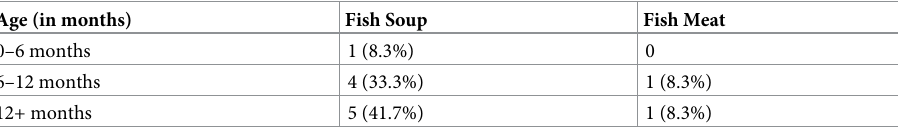
Table 3. Number of respondents who introduced fish to their child’s